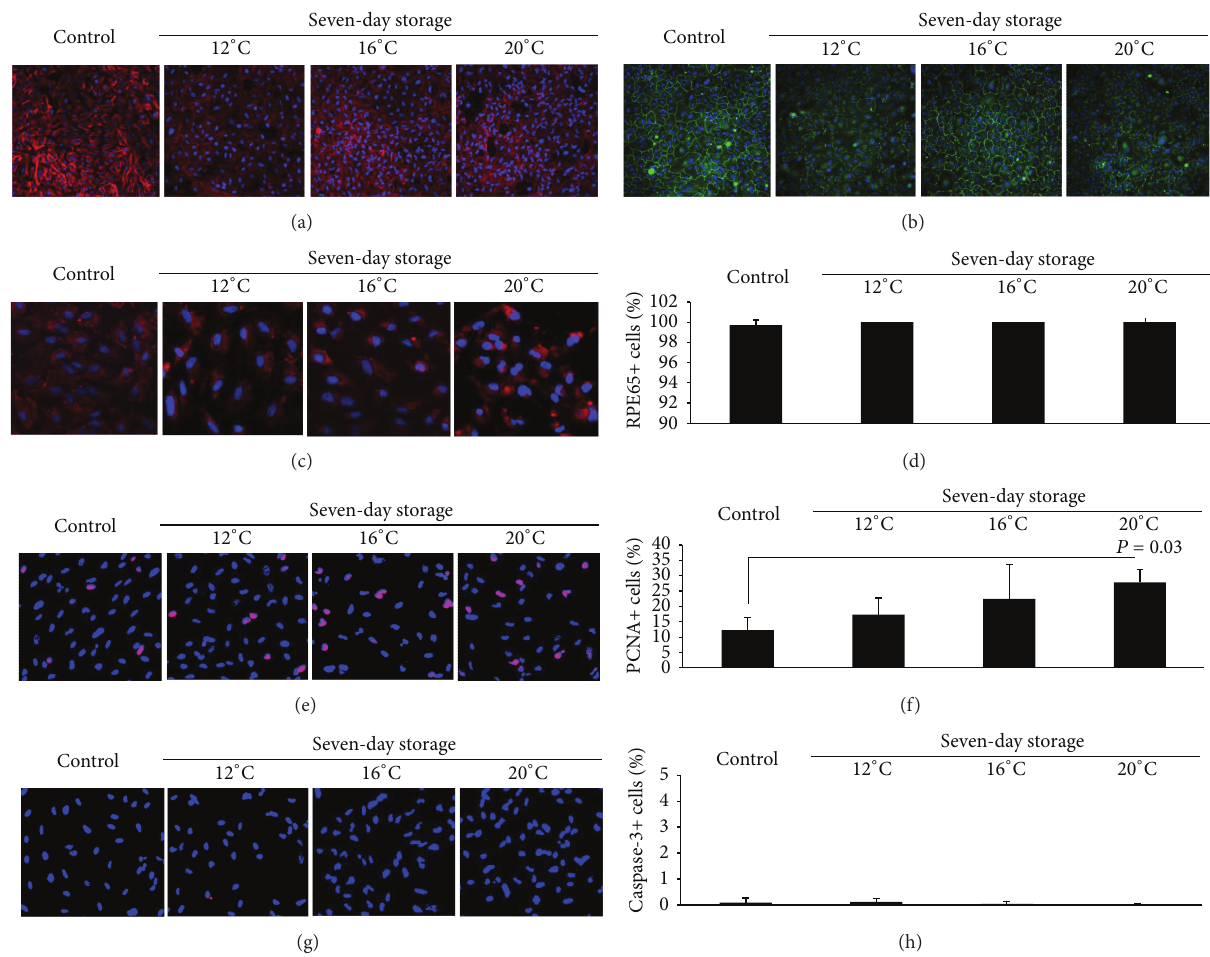
Figure 7: Cultured RPE cells were stored at 12 ∘ C, 16 ∘ C, and 20 ∘ C for seven days, and expression of actin, ZO-1, RPE65, PCNA, and caspase-3 was assessed. The percentage of cells expressing RPE65, PCNA, and caspase-3 was quantified by two independent and blinded investigators. (a) Photomicrographs showing immunostaining with phalloidin-Alexa 568 used to visualize actin filaments (red). Nuclei were stained with DAPI (blue). Original magnification: × 200. (b) Photomicrographs showing immunostaining of ZO-1 (green). Nuclei were stained with DAPI (blue). Original magnification: × 200. (c) Photomicrographs showing immunostaining of RPE65 (red). Nuclei were stained with DAPI (blue). Original magnification: × 200. (d) Bar chart demonstrating RPE65 expression in stored and control cells. Expression of RPE65 was maintained after storage at all three temperatures. Error bars: standard deviation of mean values. (e) Photomicrographs showing immunostaining of PCNA (red) in control and stored cells. Nuclei were stained with DAPI (blue). Original magnification: × 200. (f) Bar chart displaying the percentage of PCNA+ cells in the control cultures and in the storage groups. PCNA expression was maintained at 12 ∘ C and 16 ∘ C and increased after storage at 20 ∘ C compared to the control. Error bars: standard deviation of mean values. (g) Photomicrographs of cells stained with anti- caspase-3 antibody (red). Nuclei were stained with DAPI (blue). Original magnification: × 200. (h) Bar chart showing the percentage of caspase-3+ cells. There was no increase in caspase-3+ cells after storage compared to control. Error bars: standard deviation of mean